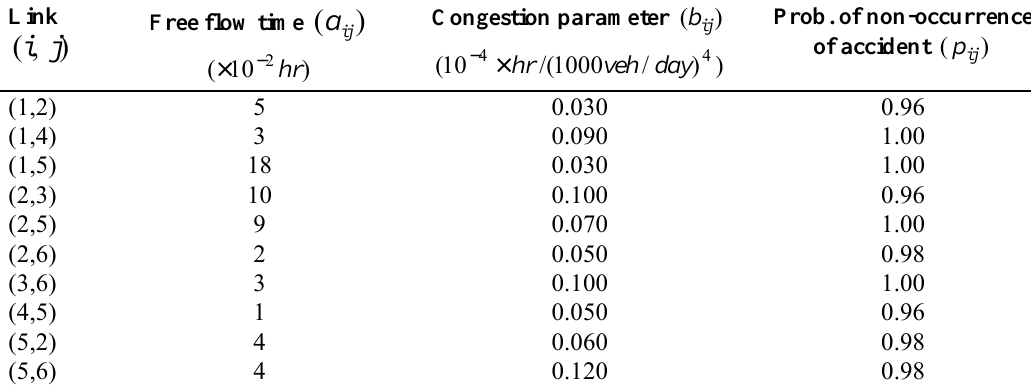
Table 1. Specifications of the links of Example Network 1.